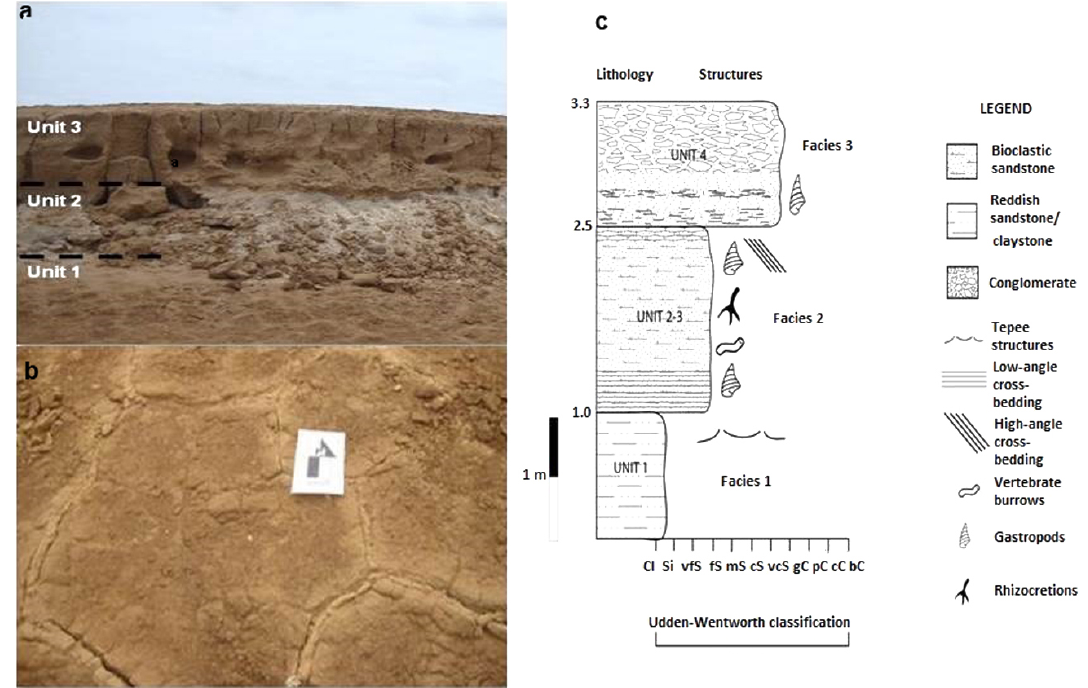
Figure 2. (a) Exposure of sedimentary units as described in the text. Nerita dated at ca. 8000 years BP sampled from unit 1. Below are “tepee” structures in unit 1 (b) , interpreted as part of a former supratidal flat. (c) A composite stratigraphic column from records at sites shown in Fig.